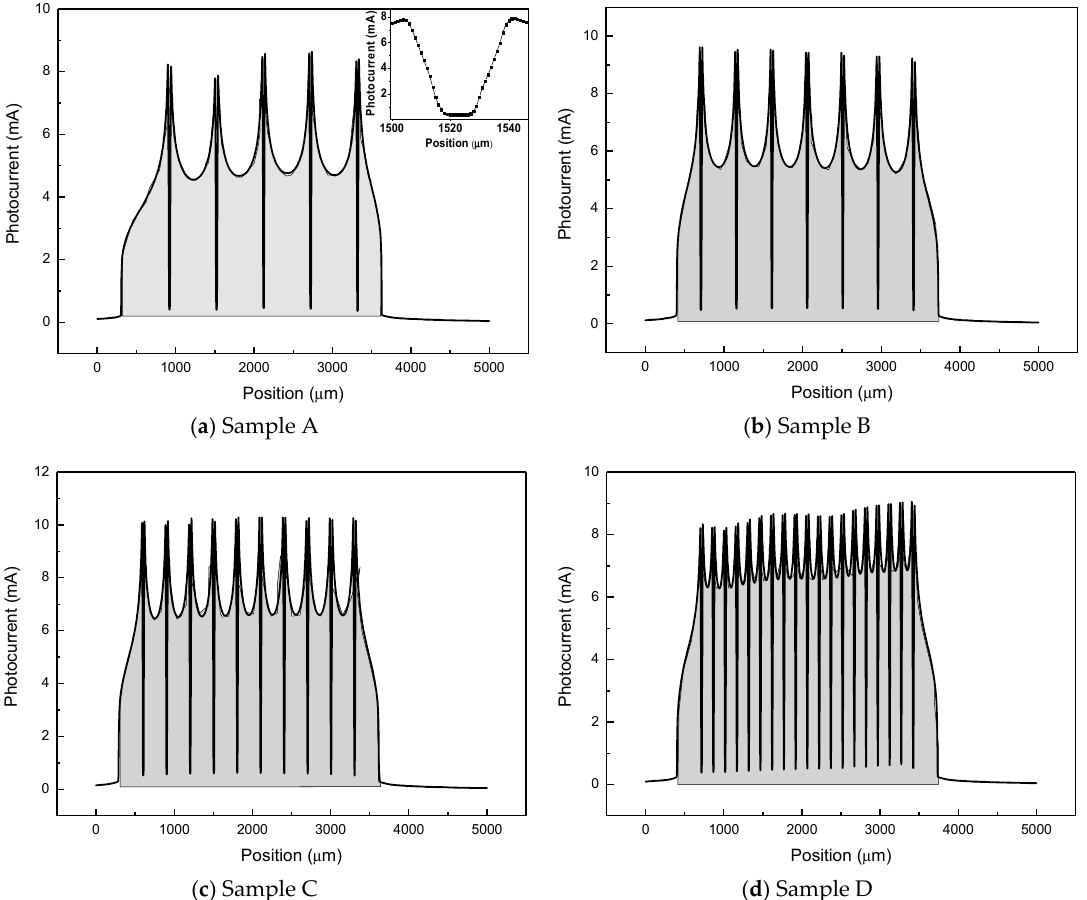
Figure 4. LBIC scanning profiles crossing the metal grids for ( a ) sample A, ( b ) sample B, ( c ) sample C, and ( d ) sample D.